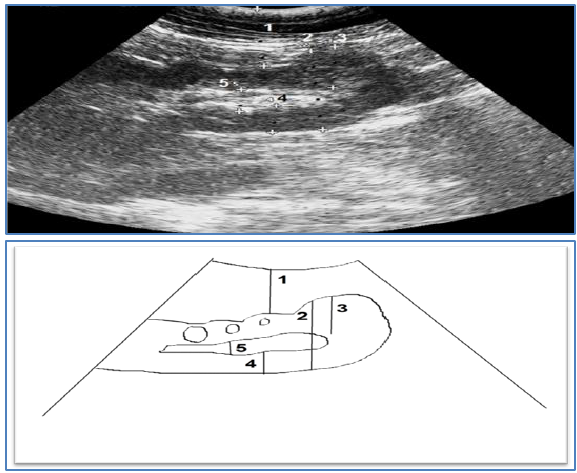
Figure, 2: Schematic represent the Ultrasonographic measurements of the right kidney of a buffalo imaged from the sublumbar fossa, 1=distance between body surface and kidney; 2=thickness of the kidney; 3=lateral cortex- medulla thickness; 4=medial cortex-medulla thickness; 5=sinus